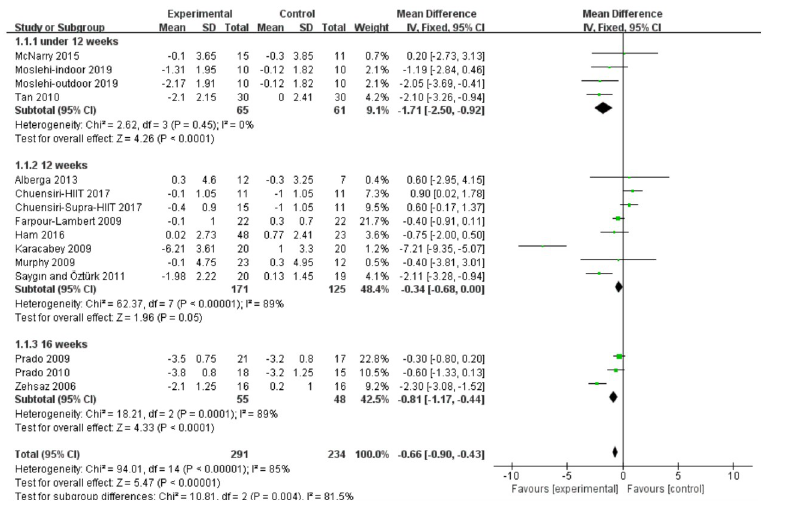
Fig 3. Forest plot of comparison: Body mass index (kg/m2).